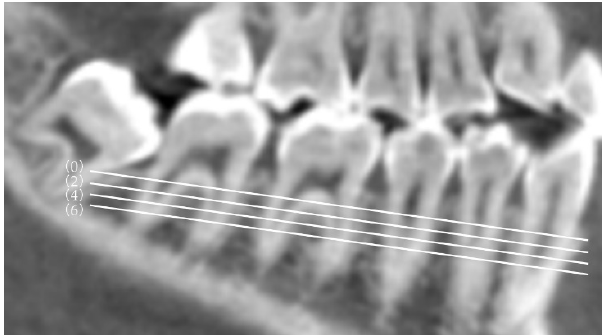
Figure 2. Plane used to measure the mandibular posterior anatomic limit to the mandibular cortex of the lingual bone. Reference plane (0) parallel to the mandibular occlusal plane passing through the root furcation of the mandibular right second molar. Reference planes (2), (4), and (6) are located 2, 4, and 6 mm, respectively, from reference plane (0) toward the root apex.